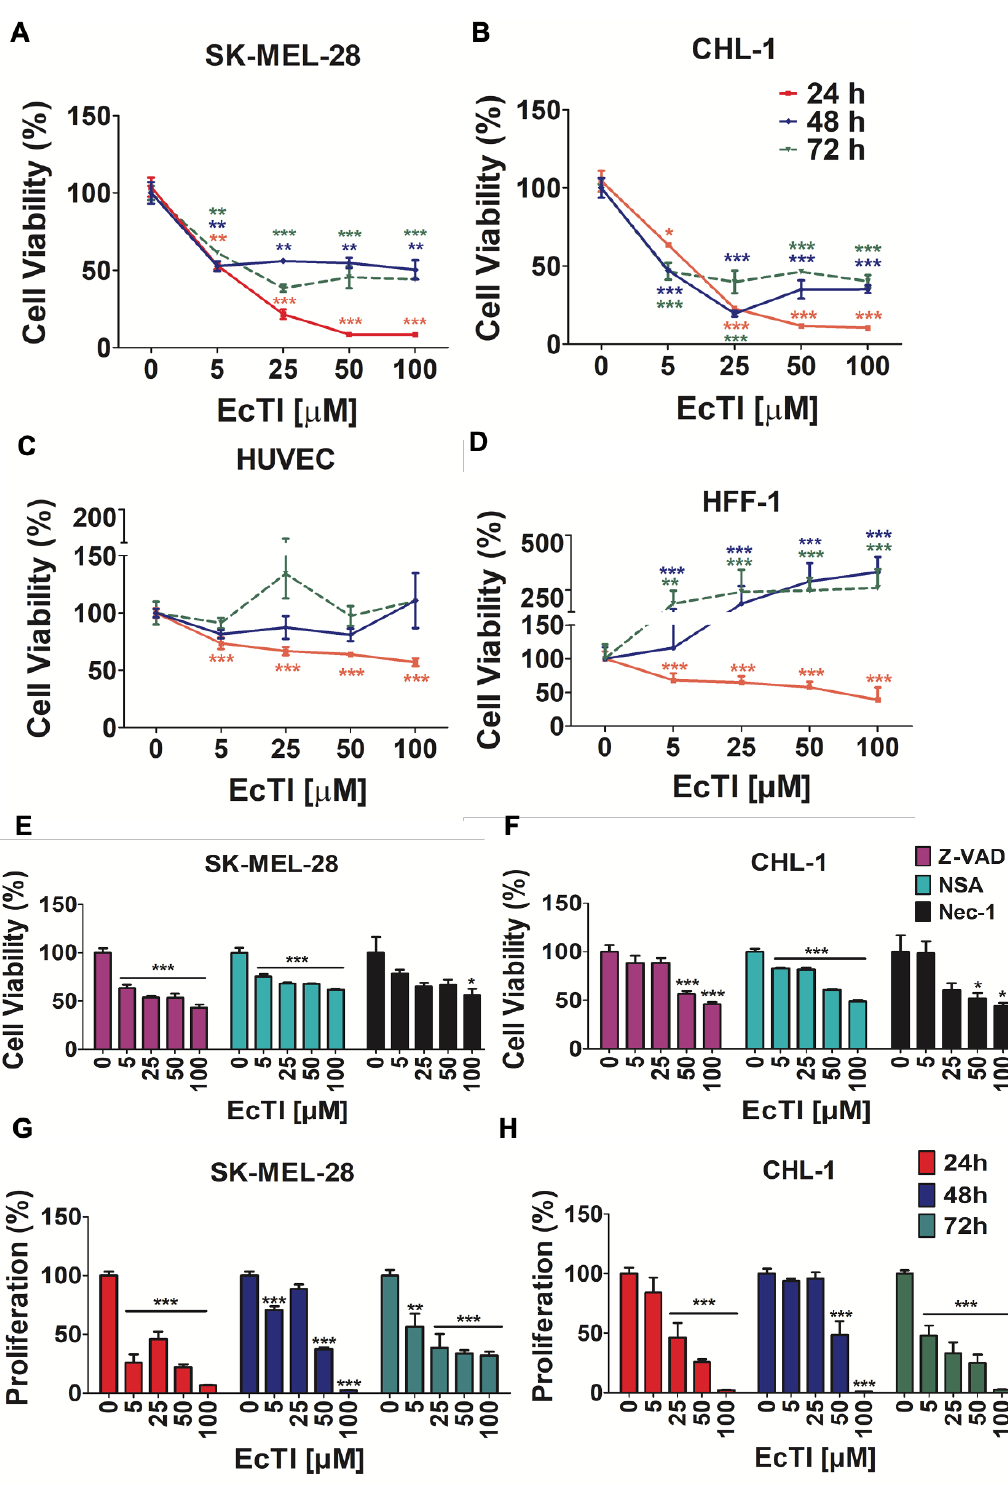
Figure 1. Cell viability and proliferation. Cell viability of SK-MEL-28 ( A ), CHL-1 ( B ), and non-tumorigenic HUVEC ( C ) and HFF-1 ( D ) was measured with increased concentrations of EcTI (5, 25, 50, and 100 µ M) after 24, 48, and 72 h of treatment. Co-treatment with apoptotic and necrotic inhibitor was evaluated after 24 h of incubation with Z-VAD (20 µ M), NSA (0.2 µ M), and Nec-1 (5 µ M) in SK-MEL-28 ( E ) and CHL-1 ( F ) cells and demonstrated the alteration of Z-VAD and Nec-1, especially. Proliferation assays were estimated by BrDU uptake in SK-MEL-28 ( G ) and CHL-1 ( H ) cells after 24–72 h of EcTI treatment. Percentage values were normalized to control cells (0). The bars represent means and SDs. Significance reflected: * p < 0.05, ** p < 0.005, and *** p <